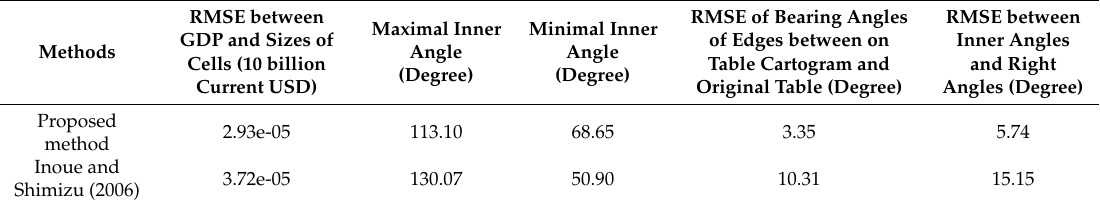
Table 2. Comparison of data representation precision and deformation by the proposed method and the method in [8].